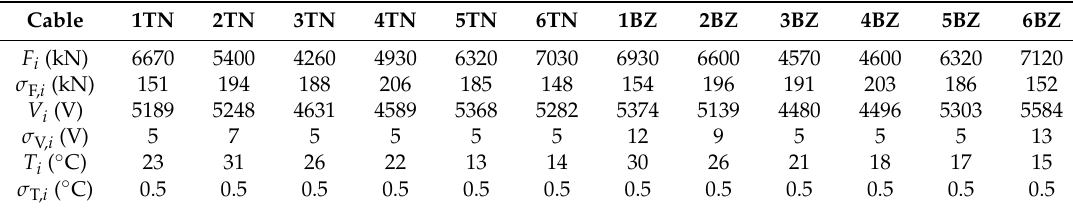
Figure 8. Standard deviation of load on cable 5TN estimated by Equation (17). Table 2. First 16 frequencies in Hz obtained with FFT. Table 3. Forces from vibration tests and voltages acquired during the in situ